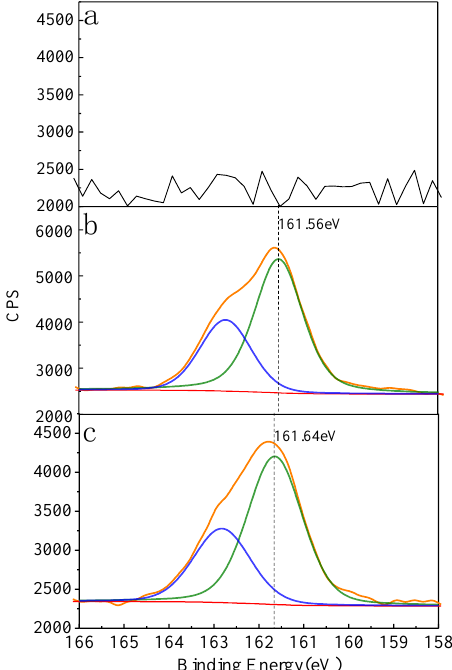
mM Na 2 S + 1mM Fe 3+ .